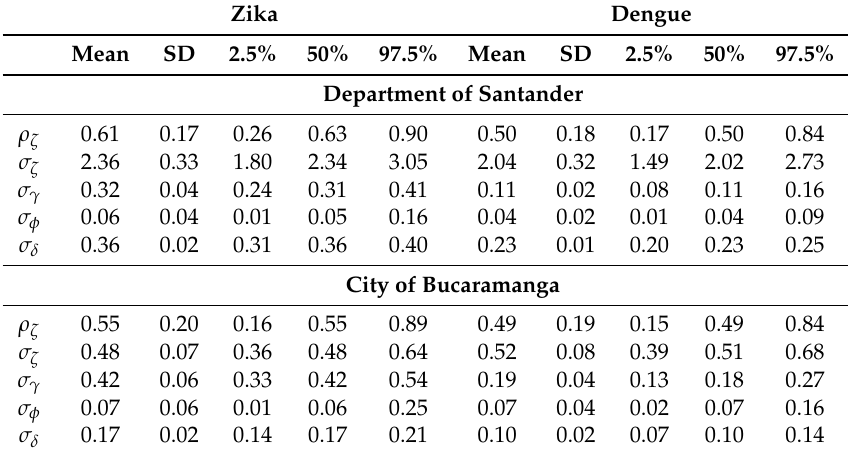
Table 2. Standard deviation hyperparameters of the interaction-effects models for the relative risk of Zika virus disease (ZVD) and dengue from October 2015 to December 2016. Posterior mean, standard deviation (SD), and 2.5%, 50%, and 97.5% percentiles. Zika Dengue